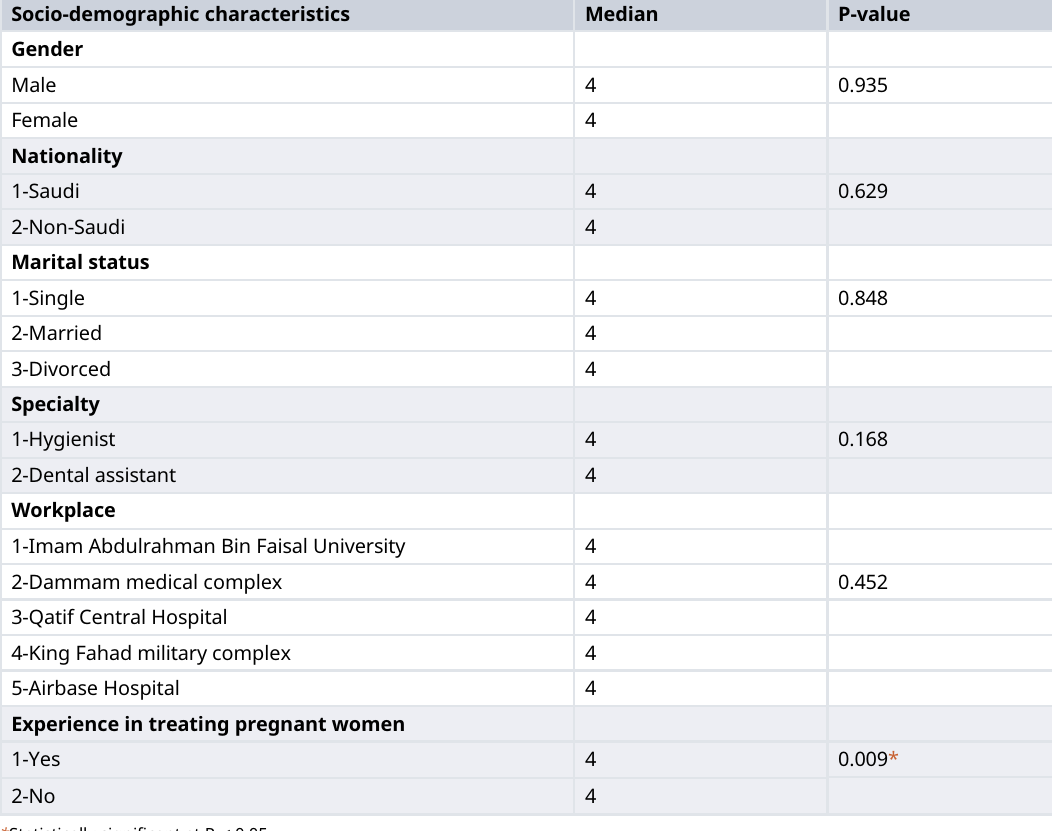
Table 5. Association of practice with socio-demographics of dental auxiliaries